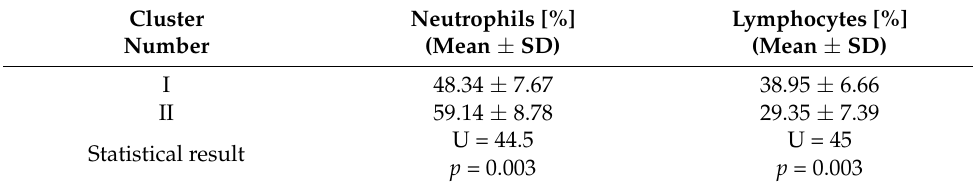
Table 3. The level of neutrophils and lymphocytes in the selected clusters of patients with schizophrenia. Cluster